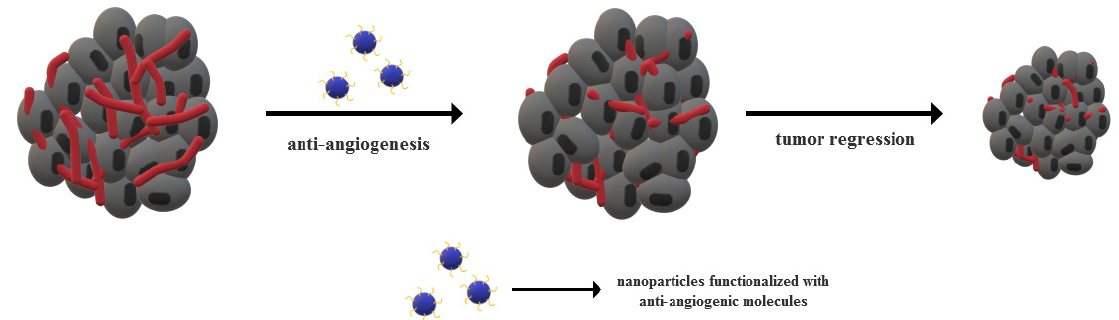
Figure 2. Nanotechnology and anti-angiogenesis combined strategies for cancer treatment.